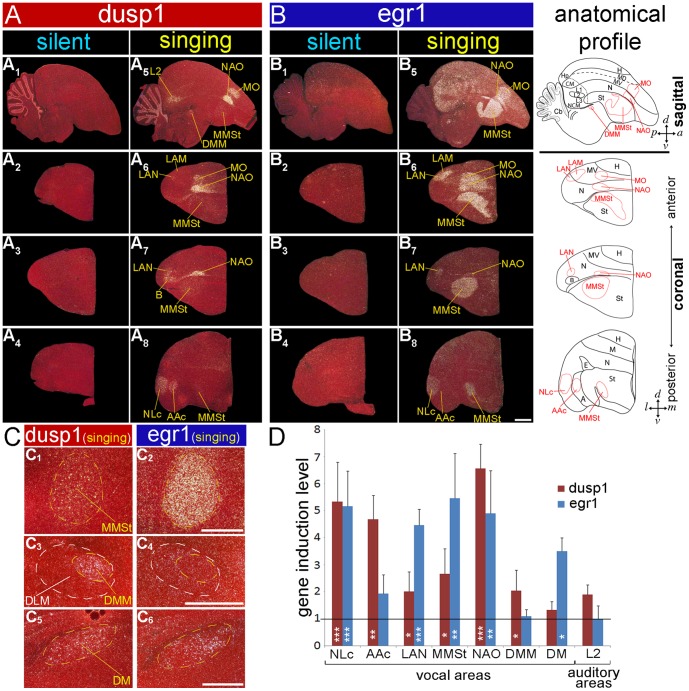
Dusp1 and egr1 mRNA expression in budgerigar brain after singing.(A) Darkfield images of in situ hybridization with dusp1 from a non-singing control (A1–4; no auditory stimulus, sitting relatively still) and a singing (A5–8) male bird that produced warble song for 30 mins. (B) Adjacent sections hybridized with egr1. Sagittal (A1,5, B1,5) and coronal (A2–4,6–8,B2–4,6–8) sections are shown. The right most column shows anatomical profiles with vocal areas highlighted in red; only the core of the MO and NAO song nuclei where we observe the dusp1 expression is drawn. (C) Magnified images of dusp1 and egr1 mRNA expression in the nuclei indicated after singing. (D) Quantification of dusp1 and egr1 expression. Values significantly above 1 indicate induced expression in singing animals (n  = 3) relative to the average of silent controls (n  = 3, overall difference p<0.001 repeated measures ANOVA; * p<0.05, ** p<0.01, and *** p<0.001 unpaired t-test for each brain region relative to silent controls). Error bars, ±SD. Scale bar  = 2 mm in B8 (applies to all A and B); 1 mm in C2 (applies to C1,2), C4 (applies to C3,4), and C6 (applies to C5,6).